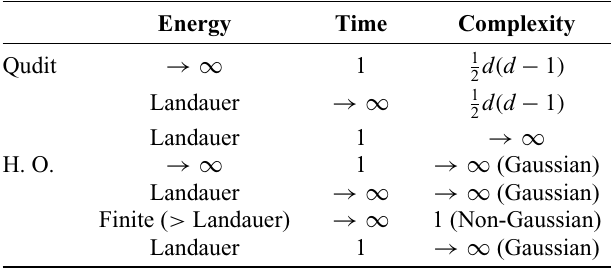
TABLE I. Coherent-control cooling protocols for finite- dimensional (qudit) and harmonic oscillator systems. Landauer energy cost refers to saturation of Eq. (4) and complexity refers to the proxy measure effective dimension (see Definition 1); time is measured as the number of unitary operations with a fixed com- plexity. In the qudit case, the system and machine dimensions are equal: d S = d M = : d